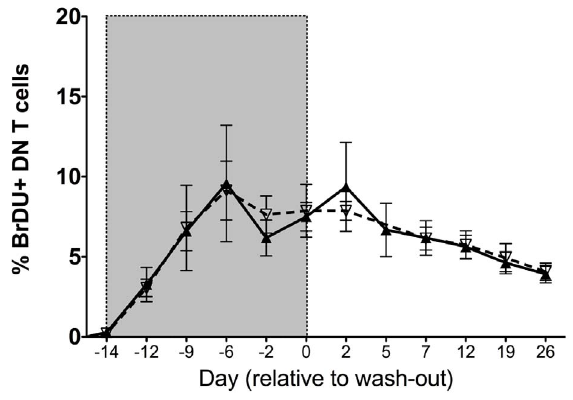
Figure 8. In vivo evaluation of proliferation and turnover of DN T cells in mangabeys. 5-Bromo-deoxyUridine (BrDU) labeling was undertaken in 3 uninfected (dotted line, mean) and 5 chronically SIV infected mangabeys (solid line, mean). Analysis of PBMCs indicates that DN T cells incorporate BrDU during the labeling phase (gray shaded area) at a similar rate in the SIV infected and uninfected mangabeys. During the wash-out phase (not shaded) the turnover rate implied by the loss of BrDU from cells was also similar between SIV infected and uninfected mangabeys. Mean 6 SEM depicted for each time point.